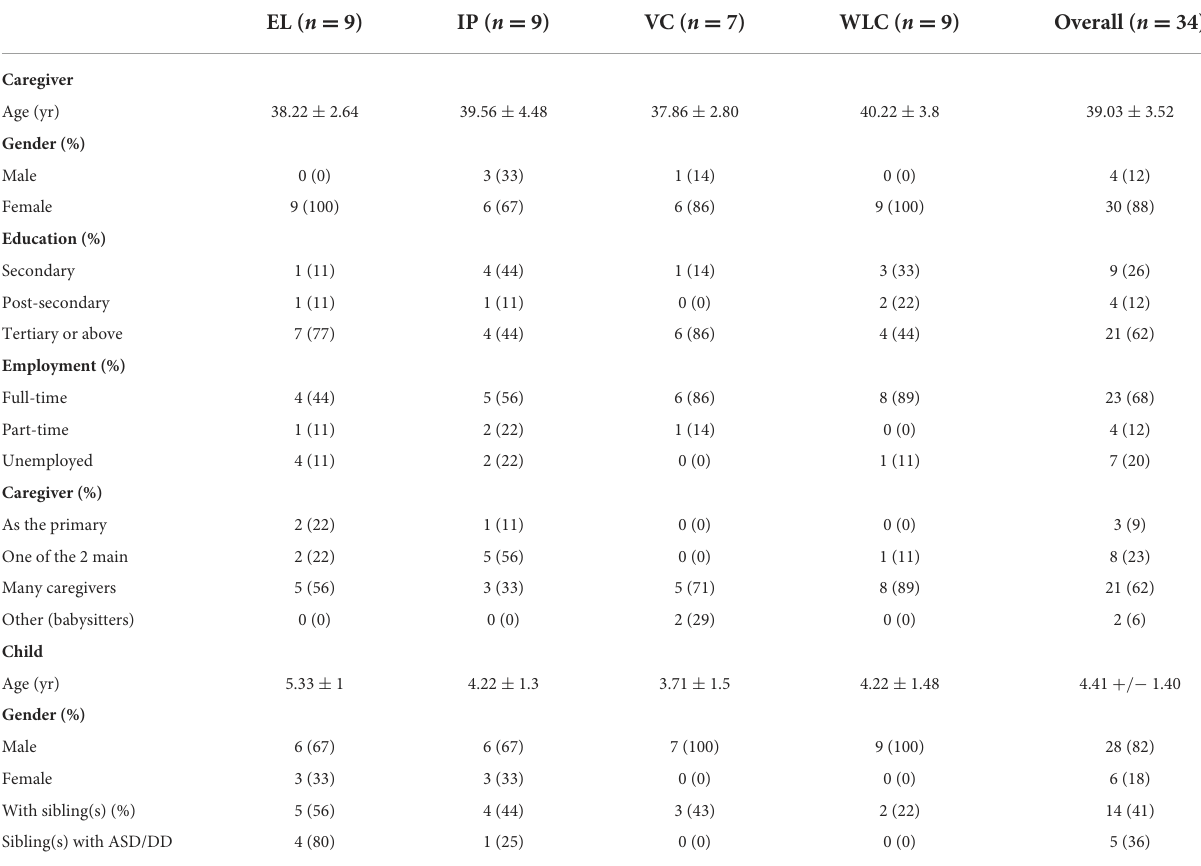
TABLE 1 Demographic characteristics of the participants.